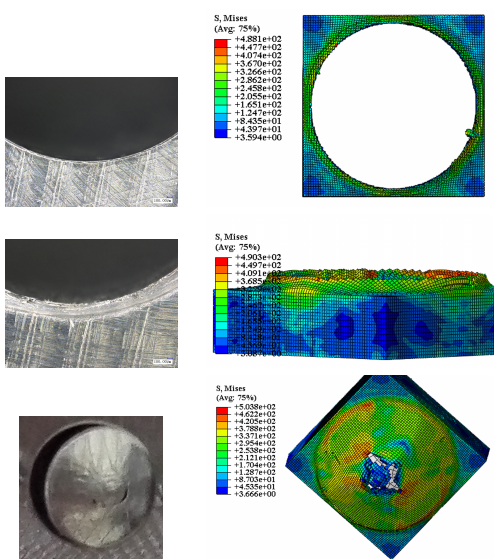
Fig. 6. Experimental and predicted results of exit burr.